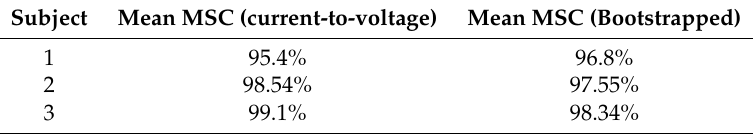
Table 1. Values of the mean of the MSC values between 15 and 48 Hz for capacitive ECG